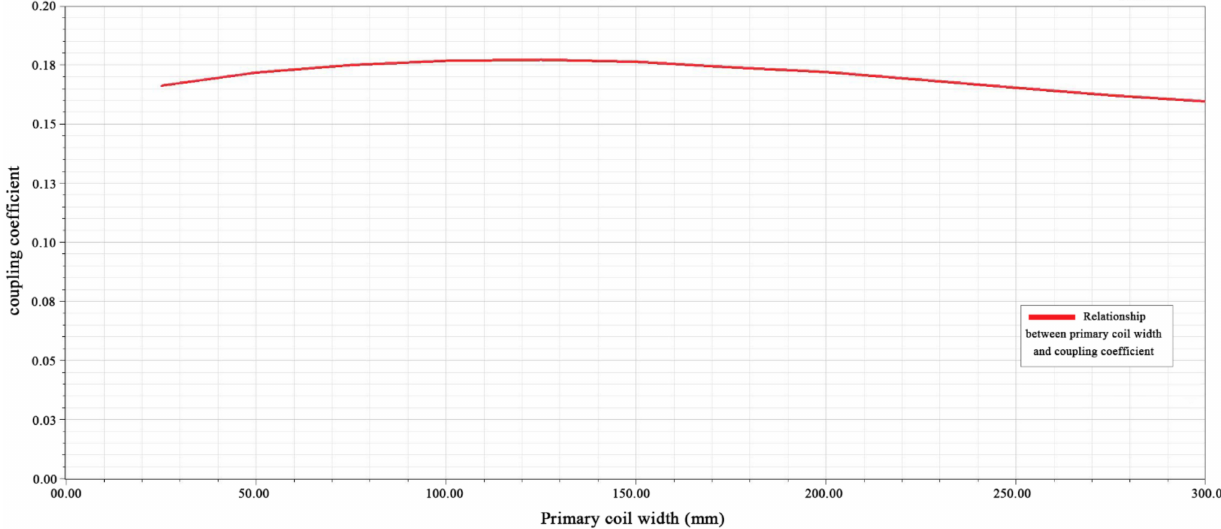
Figure 22. Relationship between the coupling coefficient of the primary coil and primary coil